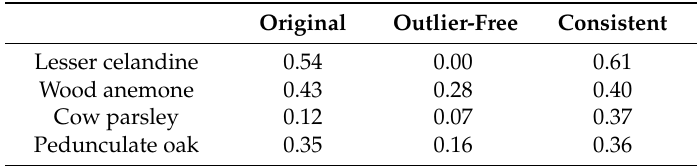
Table 2. The coefficient of determination (R-squared) of phenological synchrony models driven from original, outlier-free and consistent